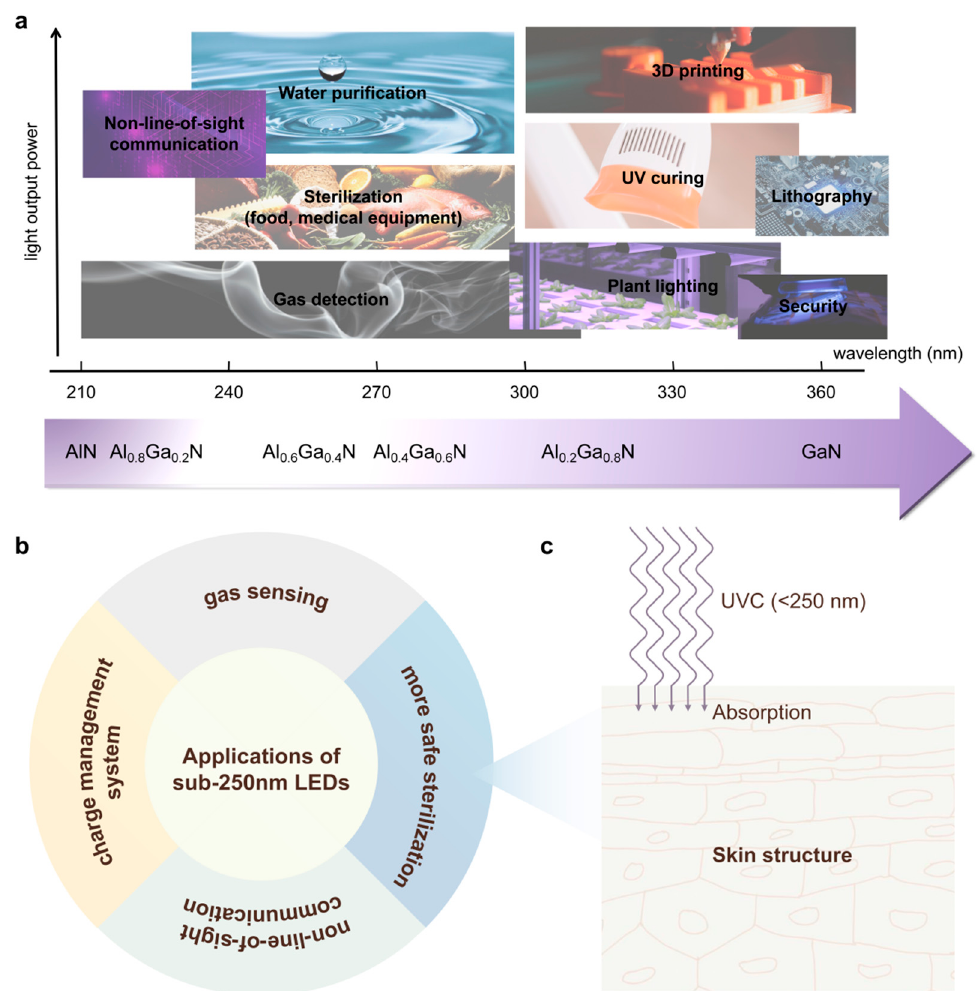
Figure 1. Partial applications of AlGaN-based LEDs of ( a ) UV band and ( b ) below 250 nm. Images are partially from internet. ( c ) Schematic of sterilization on the skin by high UVC below 250 nm.